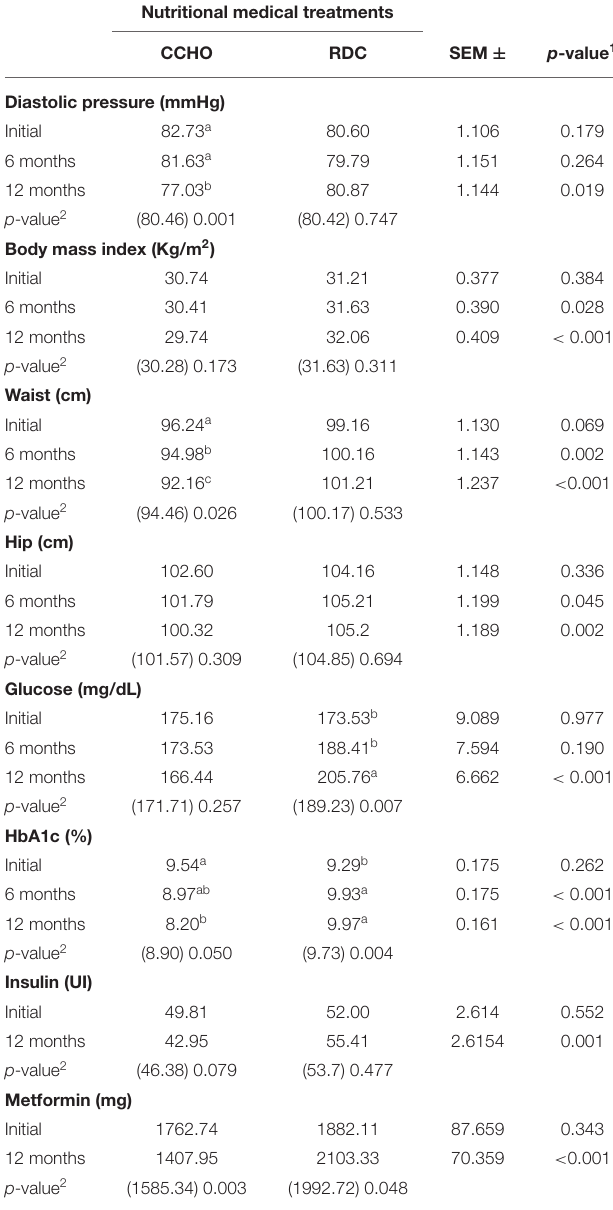
TABLE 1 | Effect of medical nutritional treatment vis-à-vis anthropometric and biochemical markers. Nutritional medical